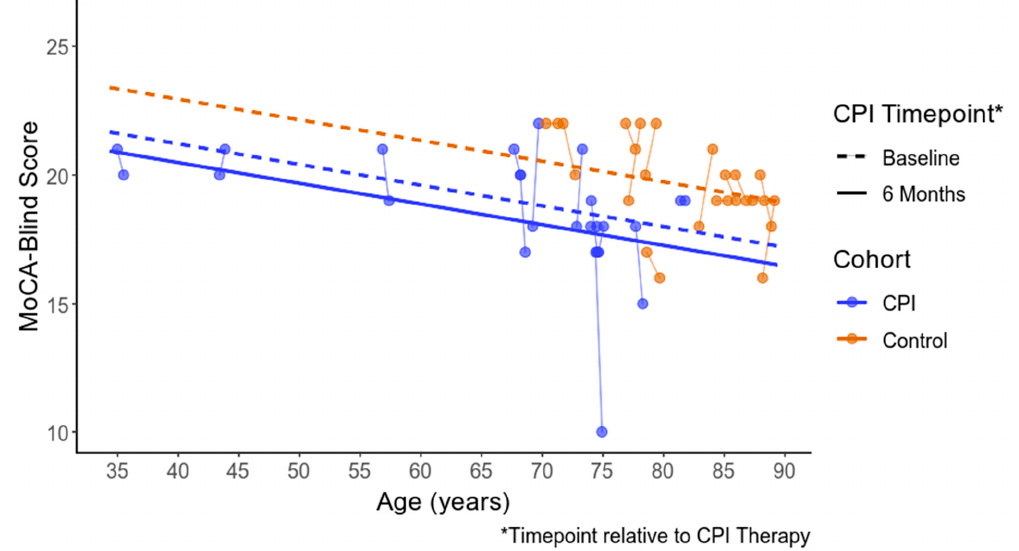
Figure 2. MoCA-Blind scores by cohort and timepoint. Table 8. Estimates for differences in MOCA-Blind scores .